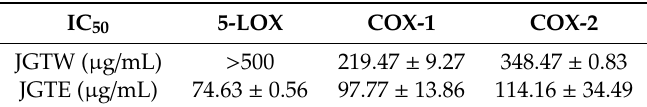
Table 1. The e ff ect of water Jakyakgamcho-Tang (JGTW) and 30% EtOH Jakyakgamcho-Tang